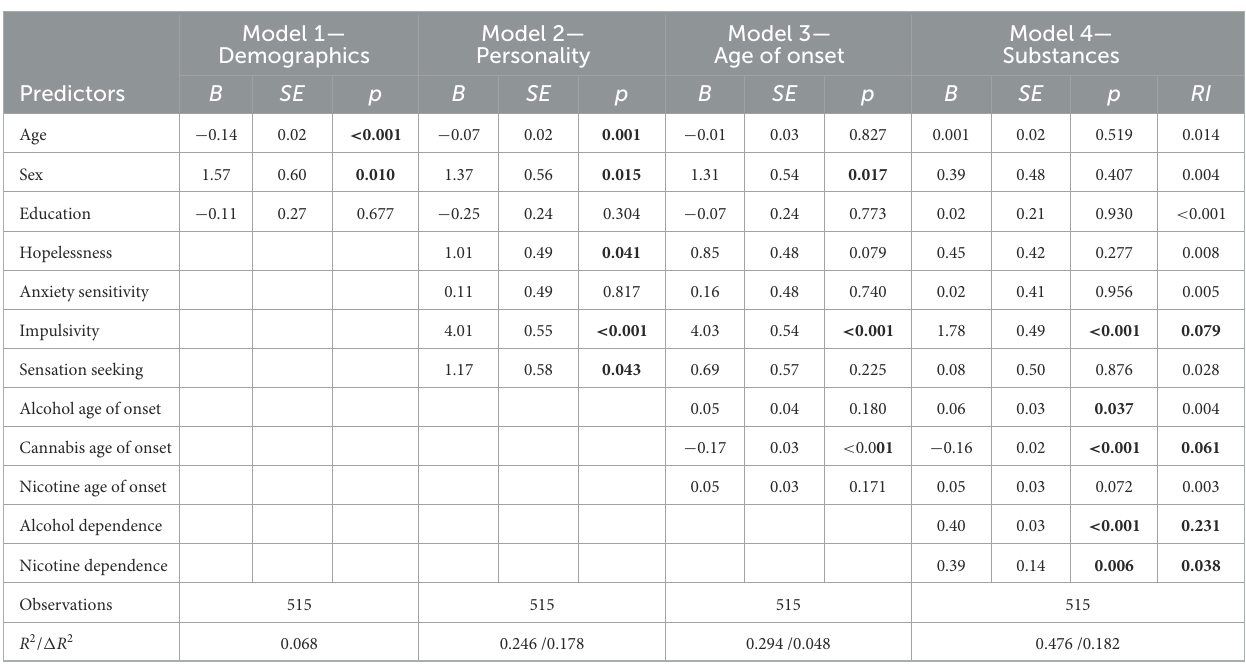
TABLE 2 Hierarchical multiple regression statistics for cannabis